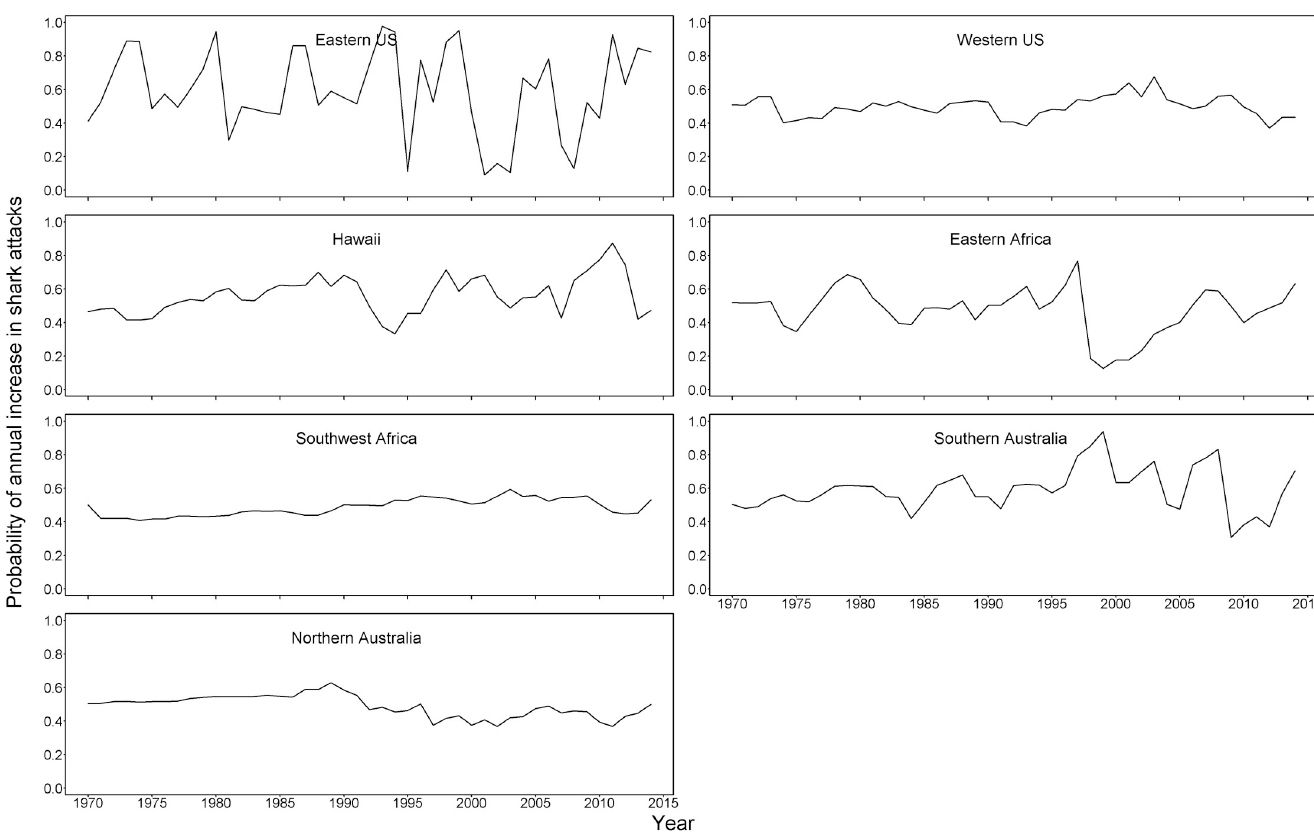
Fig 5. Annual probabilities of an increase in shark attacks rate from 1970–2015 for 7 regions in countries with the most attacks during this time.